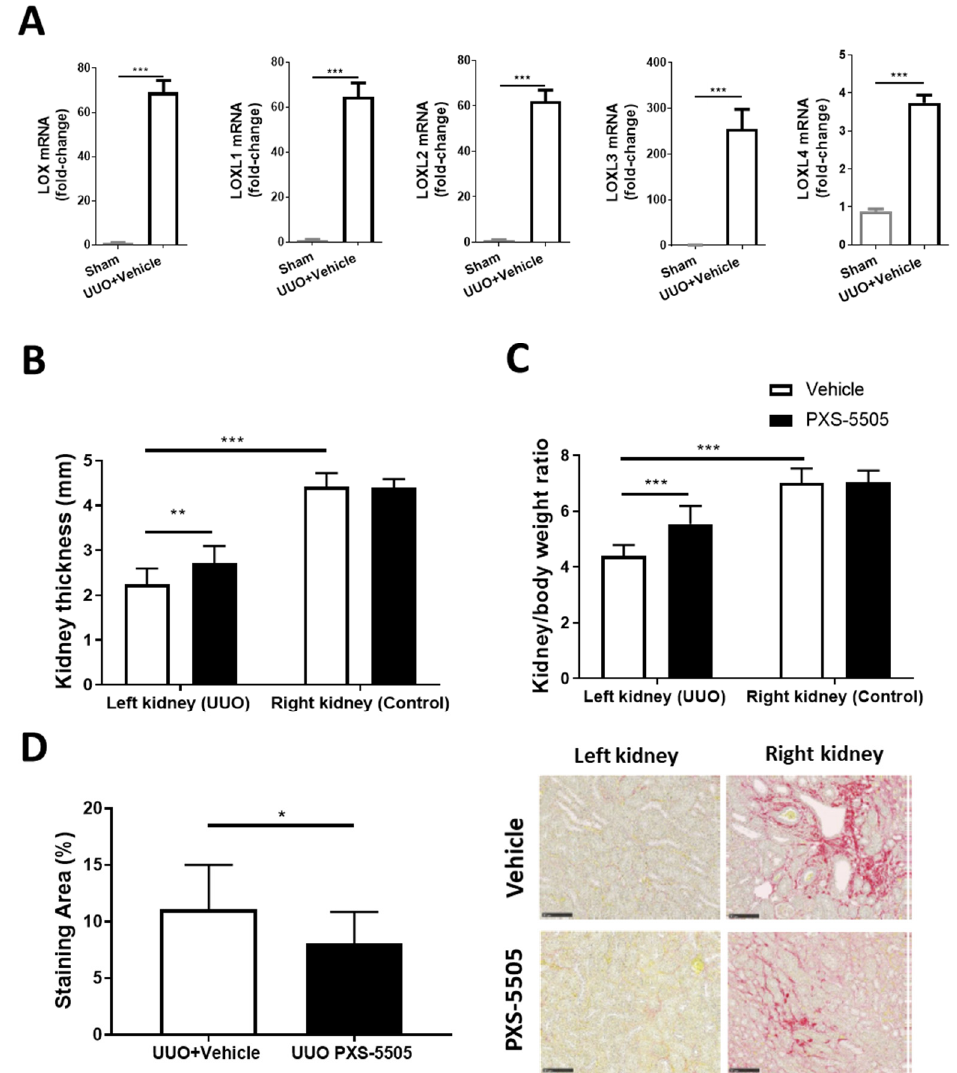
Figure 6. The effect of PXS-5505 treatment on unilateral ureteral obstruction induced kidney fibrosis and LOX over-expression in mouse kidney. ( A ) mRNA expression showing significant elevation of LOX and isoforms LOXL1-4 in the kidneys subjected to UUO compared to the control group that had been subjected to sham surgery. ( B , C ) Kidney weight and thickness measured upon sacrifice, being lowered by UUO and returned towards normal values followed by PXS-5505 treatment. ( D ) Representative images of kidney stained with Picro-Sirius red, differentiating collagen (red) from tubulointerstital tissue (yellow) with quantification of the staining area, showing significantly decreased percentage of collagen deposited area in the UUO kidneys in the animals subjected to PXS-5505 treatment compared to the vehicle treated group. Scale bar = 100 µ m (* p < 0.05, ** p < 0.01, *** p < 0.001 between the indicated